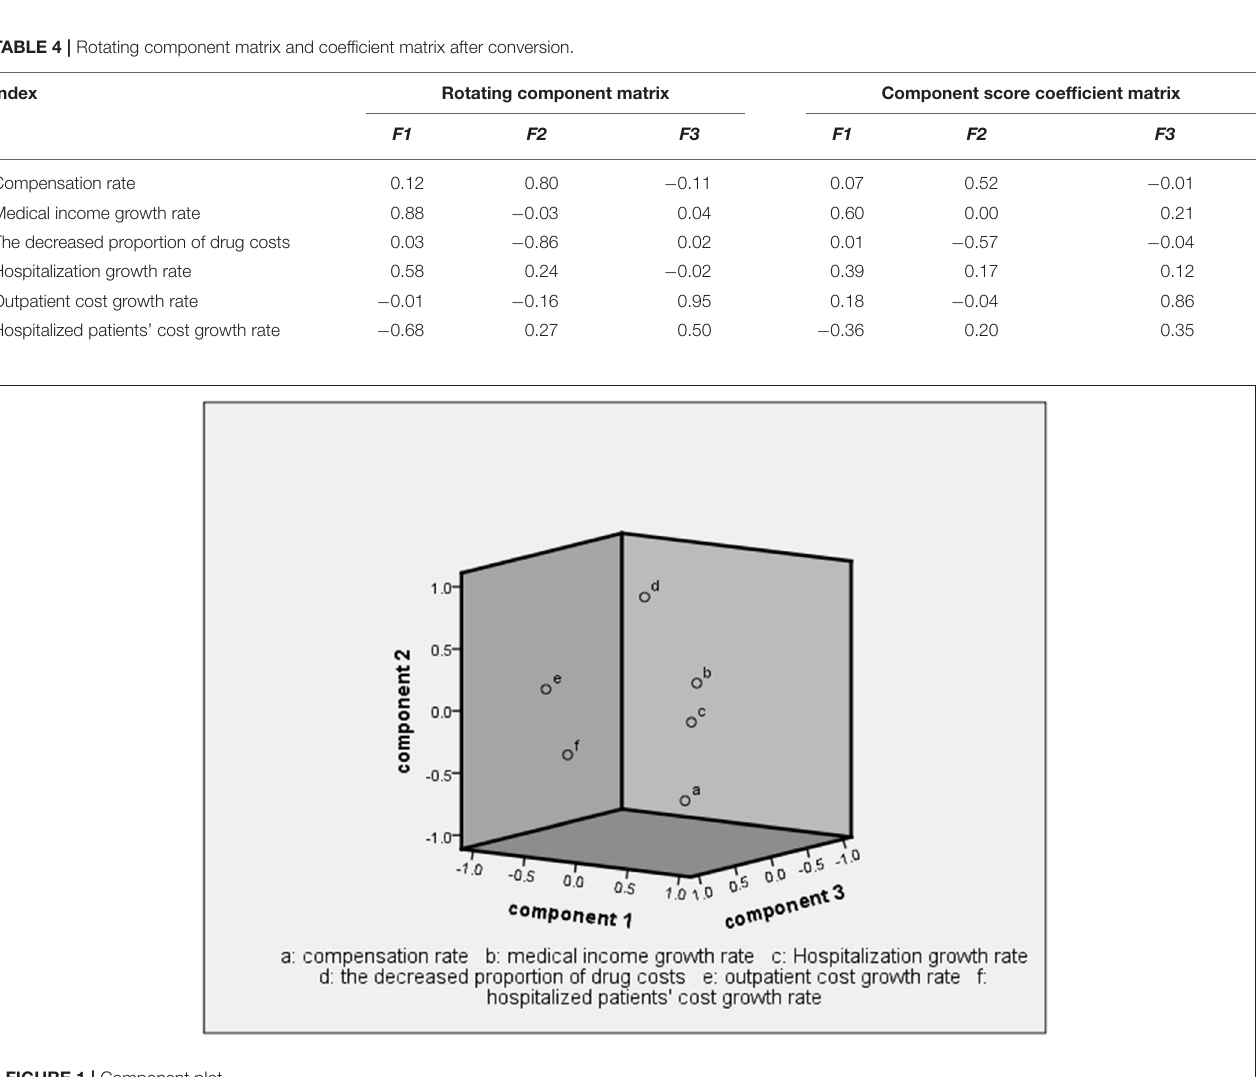
FIGURE 1 | Component